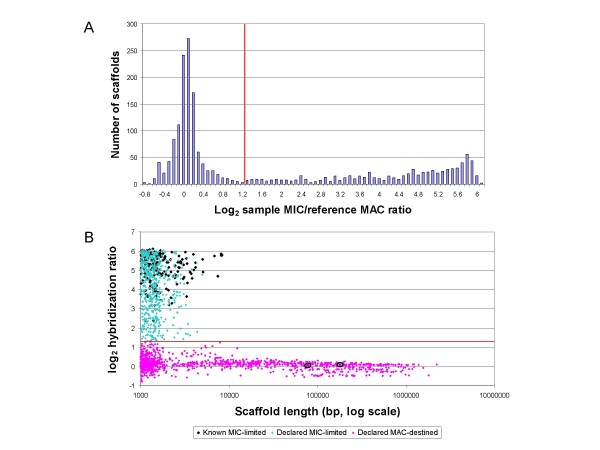
Results of MIC/MAC comparative genomic hybridization. A: Distribution of MIC scaffold ratios. Red line: proposed separation of MAC-destined (maD) DNA scaffolds (on the left) and MIC-limited (miL) scaffolds (on the right). B: Scatter plot of MIC scaffold ratios as a function of scaffold length. Pink and aqua points: maD and miL DNA, respectively, by the log2 ratio criterion in Figure 1A. Black diamonds and small black circles, respectively: miL and maD scaffolds with high sequence identity to miL transposon genes. The maD distribution is more diffuse as the length decreases to the minimum scaffold length (1,000 bp). This is attributed to the fact that the number of probes is roughly proportional to scaffold length. Given a uniform intrinsic variability in hybridization ratios for each probe, the variance of the scaffold means is expected to vary inversely with scaffold length. The secondary peak in the maD distribution (around log2 ratio = -0.45) in 1A and the multimodality of the maD distribution in 1B (most clearly seen for scaffolds > 50 kb) are caused by the partial loss of MIC chromosome segments in the cells used for the MIC DNA preps (Orias and Hamilton, unpublished observations).